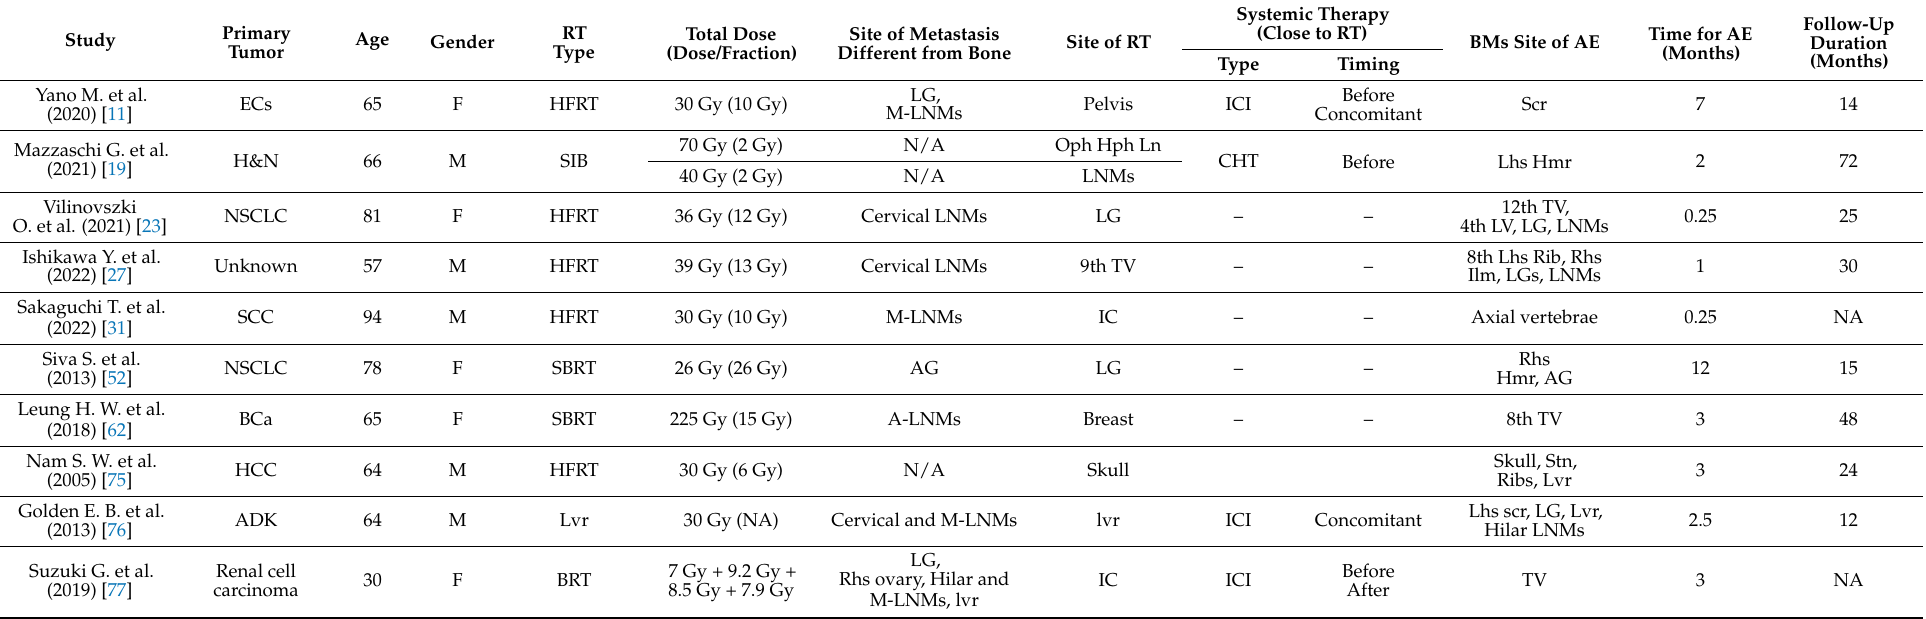
Table 1. Characteristic of the patients and treatments of case reports from the literature describing the AE of BMs.